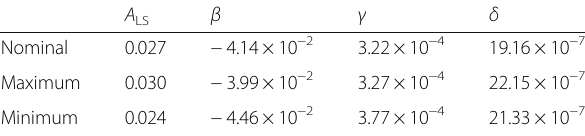
Table 2 Lommel-Seeliger functions that predict [ I / ℱ ] ( i , e , α ) (reflectance) of Ryugu at 550 nm. A LS is Lommel-Seeliger Albedo and f ( α ) = e βα þ γα 2 þ δα 3 . Table from Le Corre et al.